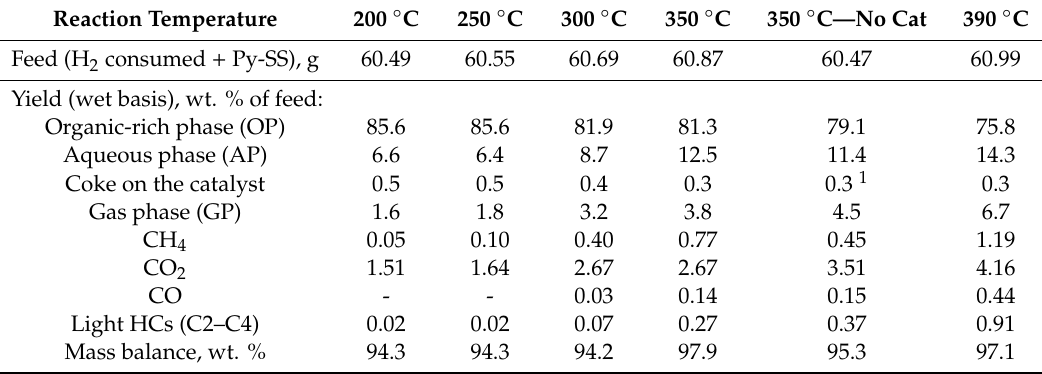
Table 2. Mass balances after hydrotreatment of Py-SS obtained from sewage sludge.